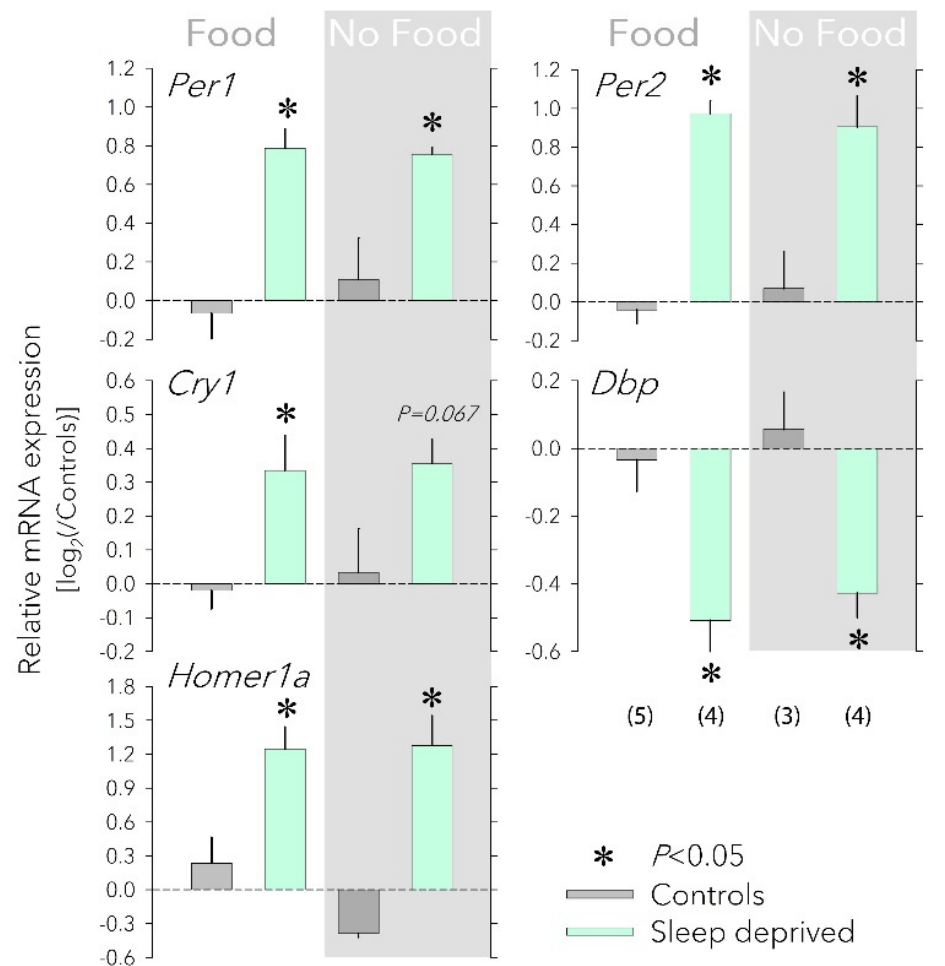
Figure 1. Effects of food availability on cortical clock gene expression. Having access to food (‘Food’, left) or not (‘No Food’, right, grey background) during a sleep deprivation (SD) did not affect the SD-induced changes in the cortical expression Per1 , Per2 , Cry1 , Dbp, and Homer1a . Values for each transcript were first expressed relative to the expression of three housekeeping genes ( Eef1a , Gapdh , and Rsp9 ) within each sample and subsequently to the mean of the two control groups (0 level, dark-grey bars) that each accompanied the SD (mint bars) of the two food conditions. Number of mice for each group in parentheses (error bars reflect 1 SEM). Food did not change the SD response (two-way ANOVA factor ‘Food’ p > 0.57, factor ‘SD’ p < 0.0021; interaction p > 0.17 for each of the five transcripts). Asterisks designate a significant SD effect within each food condition (two-sided post hoc t -tests; p < 0.05). mRNA levels of housekeeping genes were not affected by either SD or food access (not shown). All tissues were collected at